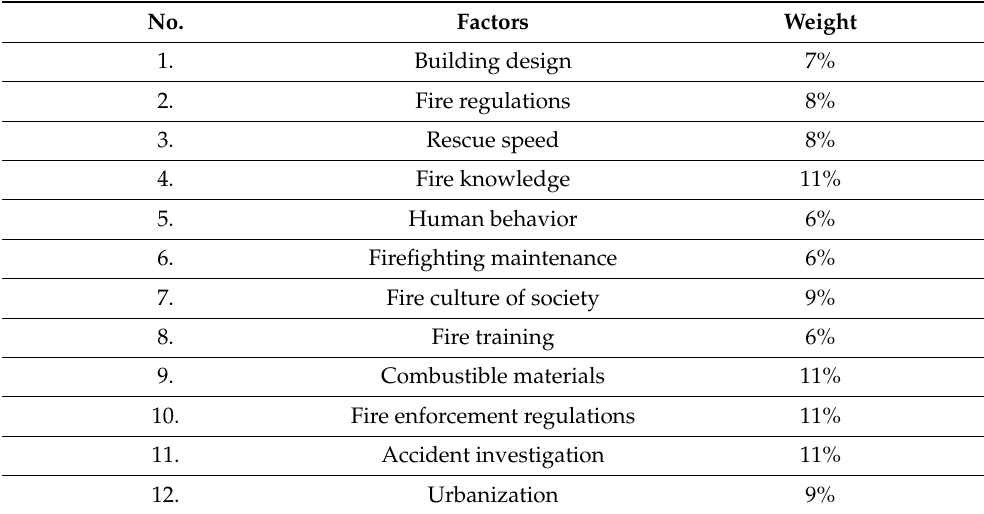
Table 7. Critical factors effecting the fire management in the HRBs in the Emirate of Sharjah.